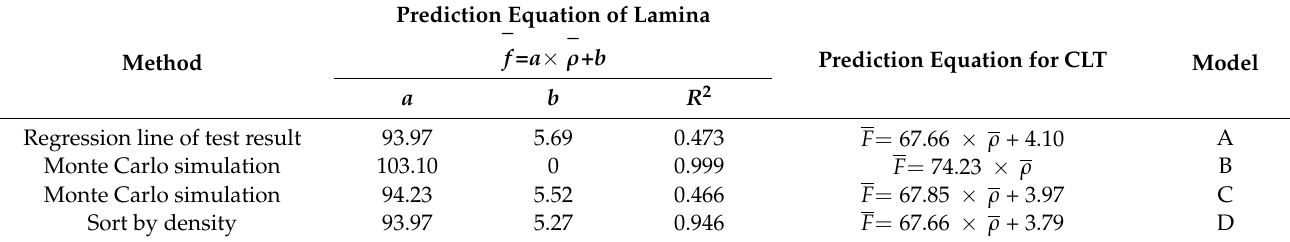
Table 7. Equations used to calculate the average compressive strength of CLT.